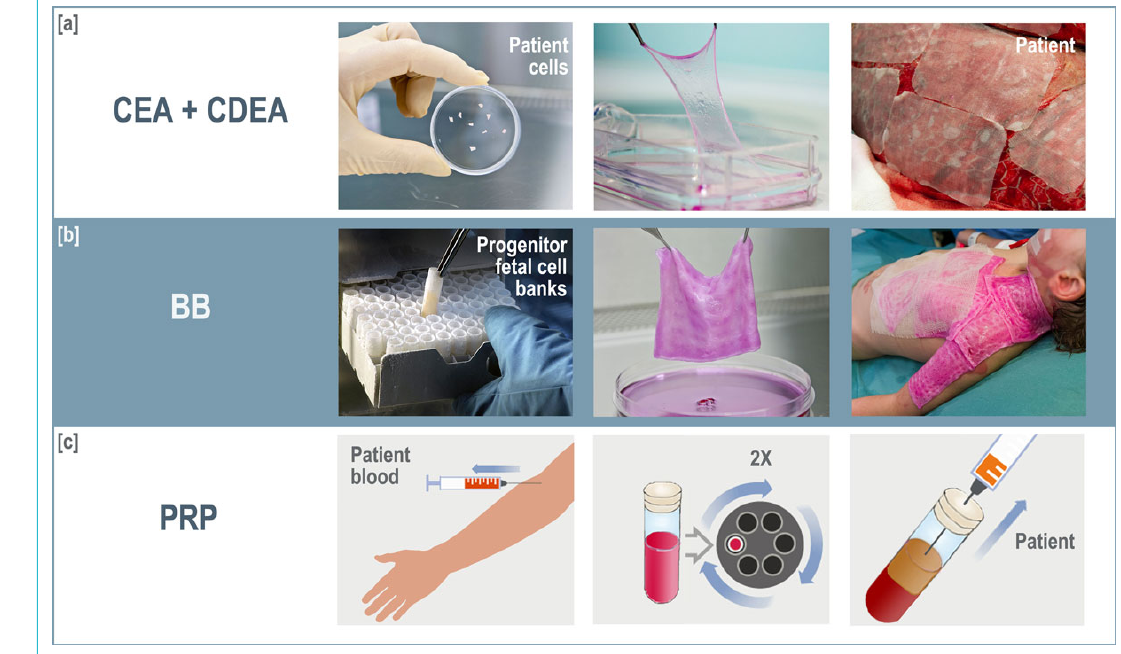
Figure 4: Different types of cell therapy used at the CHUV Burn Centre. [a] Cultured epidermal autograft and cultured dermal-epidermal auto- graft (CEA and CDEA) – keratinocytes are cultured on feeder cell layers for cell expansion, fibroblasts are retrieved from dermis explants (left panel). In the case of a CDEA, parallel culture of fibroblasts is done, and the keratinocytes are applied on the fibroblast layer after expansion. Finally, the cell sheet (middle panel) is washed with PBS and applied on patient with gauze (right panel). [b] Biological bandage (BB) – a vial from the cell bank (left panel) is thawed, and cells are seeded on a collagen matrix and incubated overnight in culture medium (middle panel), then washed and applied to patient (right panel). [c] Platelet rich plasma (PRP) – blood is collected, centrifuged in a two-step process to iso- late platelets, which are then applied to the